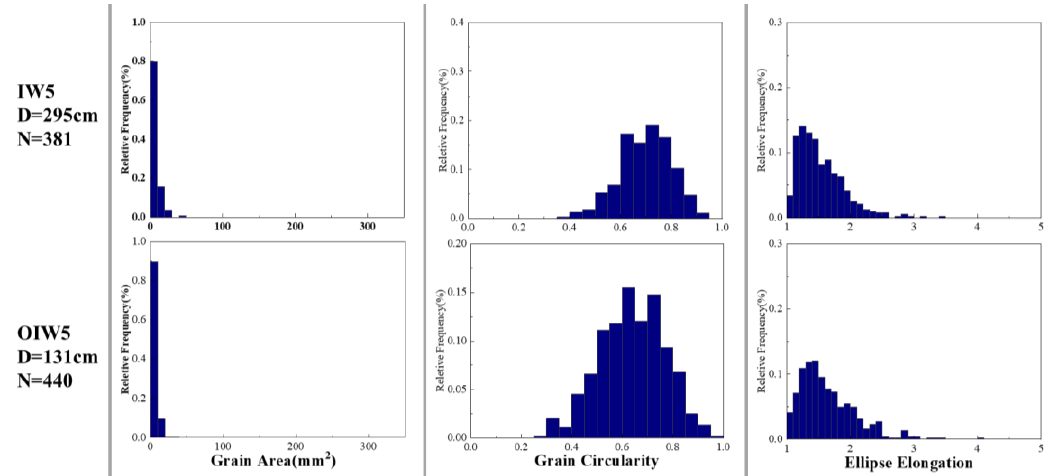
Figure 4. Grain frequency distribution diagrams. ‘D’ means depth, ‘N’ means number of grains. ( a ) Frequency distributions of grain size (mm 2 ); ( b ) frequency distributions of grain circularity; ( c ) frequency distributions of grain ellipse elongation.